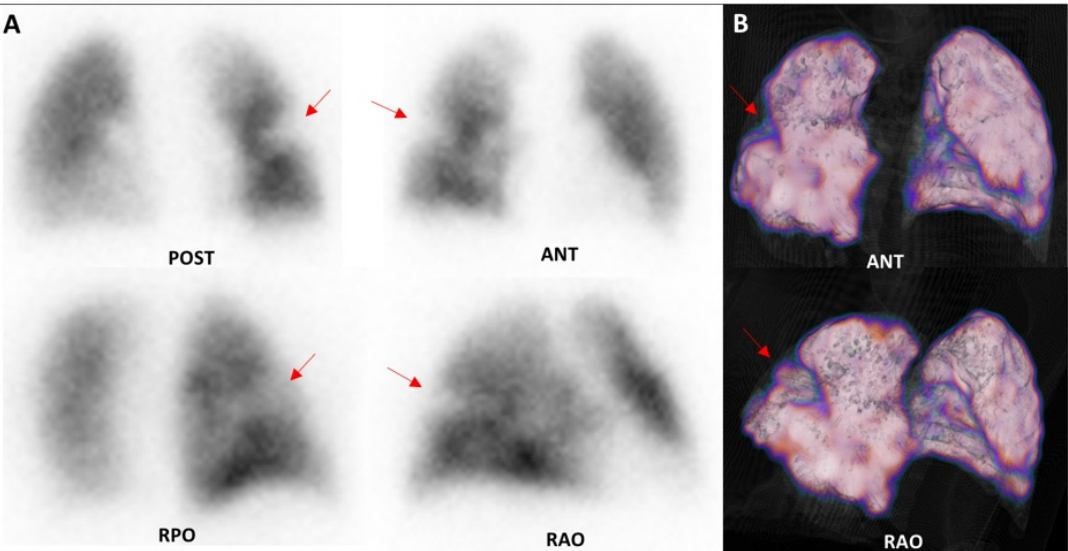
Figure 5. Lung perfusion scintigraphy performed for the suspicion of APE in a 79-year-old patient with dyspnoea, left chest pain, increased d-dimer values (842 ug/L, n.v. < 500), and chronic renal failure. Planar acquisitions ( A ) and tomographic 3D reconstruction ( B ) demonstrated a single wedge-shaped subsegmental perfusion defect in the posterior segment of the right upper lobe, thus confirming the suspicion of APE. Consequently, anticoagulant therapy was planned, and after one day of critical parameter monitoring, the patient was discharged early with adequate home therapy. POST: posterior; ANT: anterior; RPO: right posterior oblique; RAO: right anterior oblique.